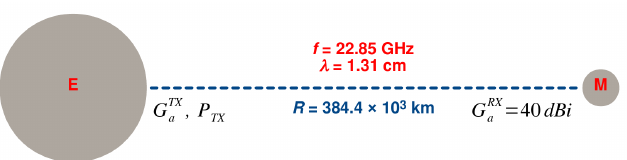
Figure 1. Link geometry. To estimate the maximum signal level the receiver is assumed on the Moon (M) surface, perfectly at the ground station Zenith on Earth (E). Link parameters: R = 384.4 × 10 3 km, transmitted power P TX = 100W, transmitting antenna gain G TX a = 65dBi (10 m dish antenna with a 60% efficiency), receiving antenna gain G RX a ≈